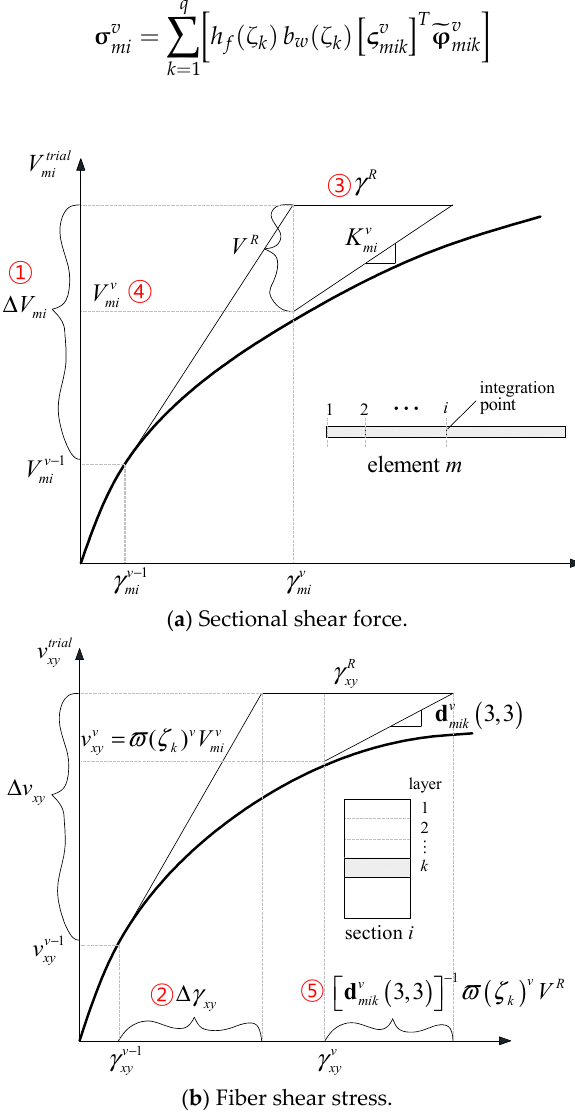
Figure 7. Shear force determination.